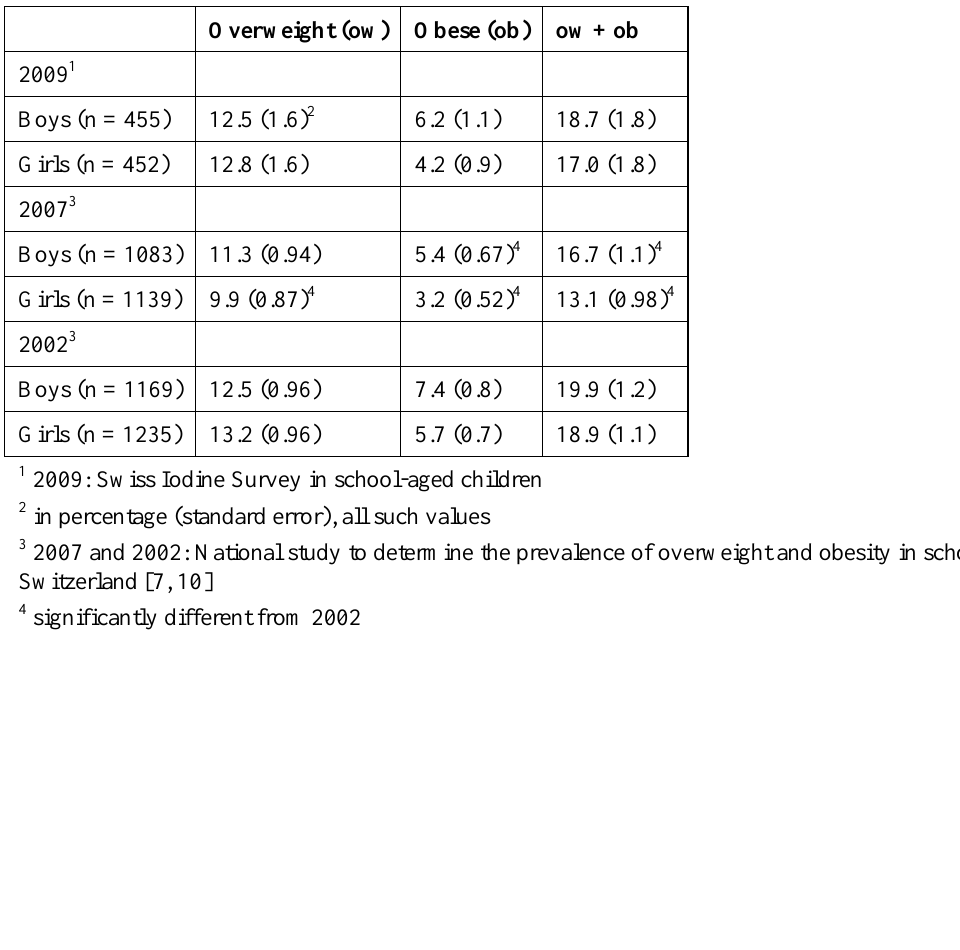
Overweight and obesity prevalence in Swiss schoolchildren from three national studies conducted 2002, 2007 and